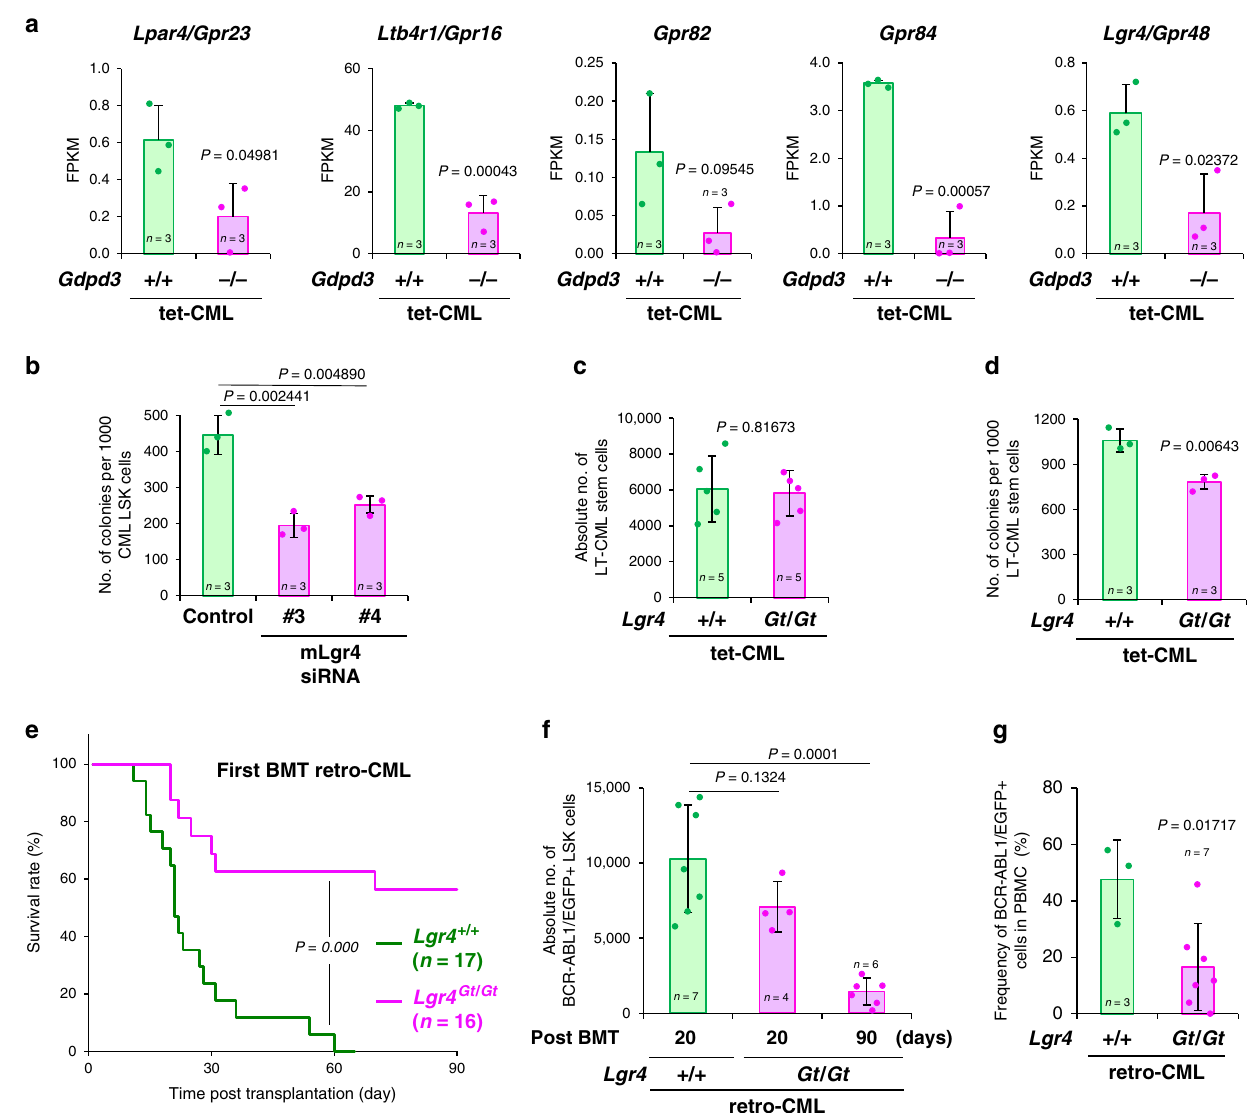
Fig. 7 Lgr4/Gpr48 is involved in CML stem cell self-renewal in vivo. a RNA-Seq determinations of mRNA levels of the indicated GPCR family genes in